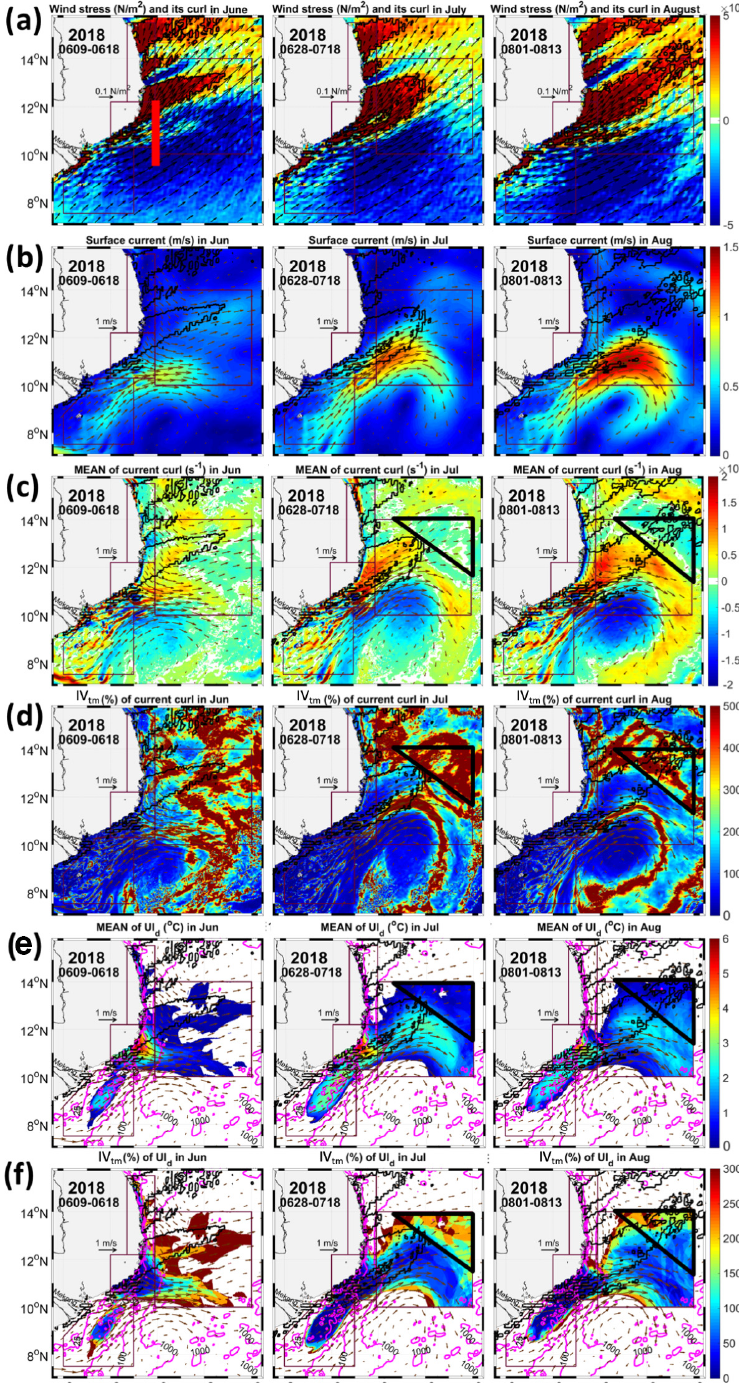
Figure 3. Maps of ensemble average of average wind stress ( a , arrows, Nm − 2 ) and wind stress curl ( a , colors, Nm − 3 ), average surface current speed ( b , ms − 1 ), vorticity ( c , s − 1 ) and UI d ( e , ◦ C) on the day of maximum UI d , boxOF over each period of the OFU development highlighted in blue in Fig. 2 (left June, middle July and right August), and maps of relative intrinsic variability (IV tm ) of average surface current vorticity ( d , %) and UI d ( f , %) over each period. Black lines: 3.10 − 7 Nm − 3 iso-contours of average wind stress curl. Red segment (a) : meridional transect at 109.9 ◦ E, 9.5–12.2 ◦ N used to compute the eastward jet strength. Arrows (b–f) : average surface current during each period. Black triangles (c–f) : area of large current vorticity north of the eastward jet during the July and August periods. Pink lines (e, f) : isobaths